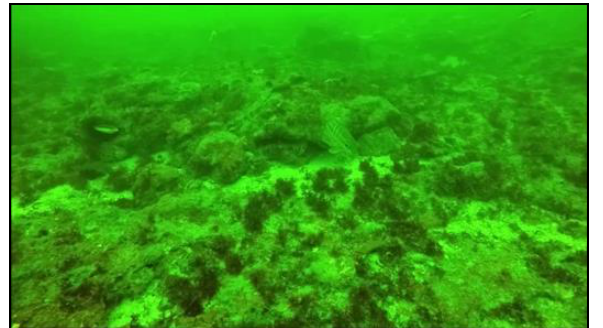
Figure 6 . example of a frame image from the underwater video.